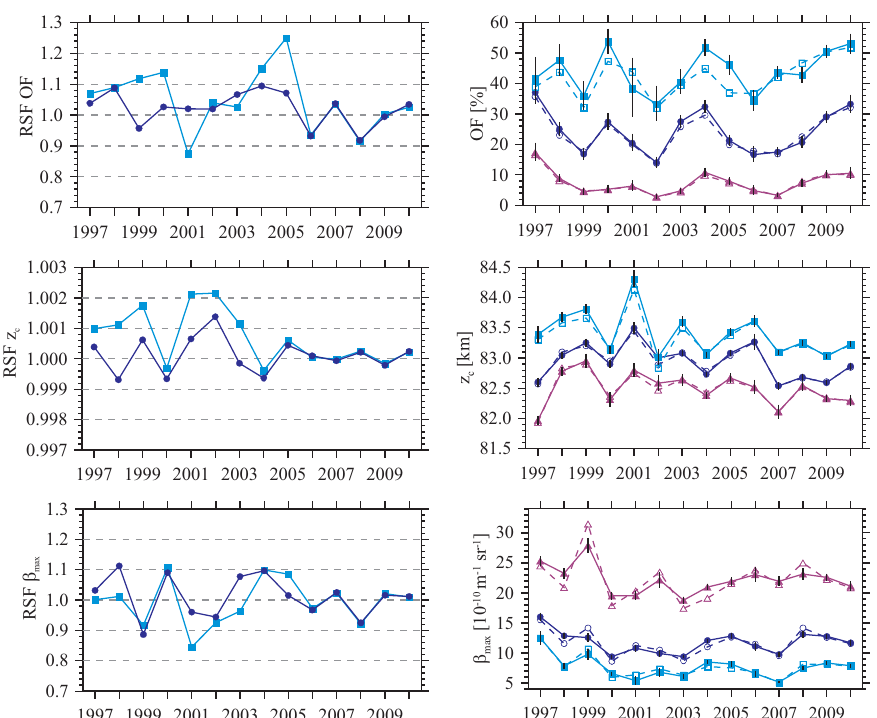
Fig. 3. Seasonal mean relative sampling factors RSF (left) and mean values (right) of NLC occurrence (top), altitude (middle) and brightness (bottom). Sampling curves are calculated for two data sets: long-term (blue circles) and high-sensitivity (light blue squares). Curves at the right side are for three brightness classes: β max > 1 (light blue squares), β max > 4 (blue circles), β max > 13 (purple triangles). Dashed lines and open symbols are corrected regarding the sampling quality. Vertical bars indicate confidence limits for the occurrence at 95%-level and errors of the means for altitude and